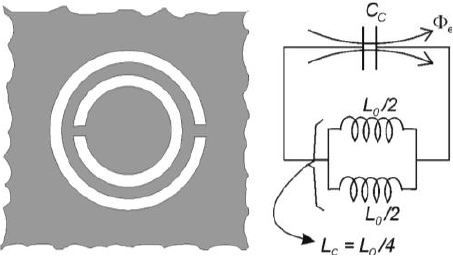
Figure 6. Complementary split ring resonator (CSRR) topology and its equivalent circuit model. Geometrical parameters of the CSRR are identical to those of Figure 3 referred to the